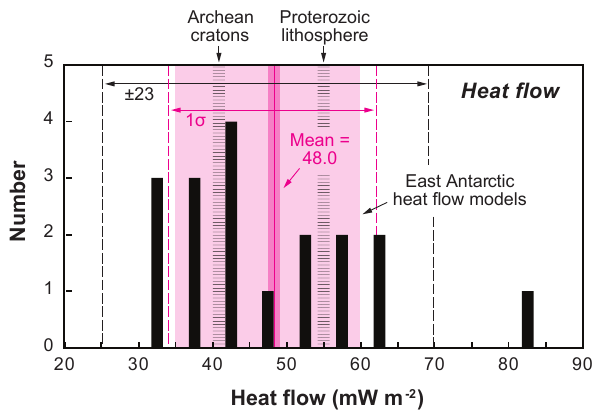
Figure 5. Histogram of heat flow values estimated from heat pro- duction in the glacial clasts. Mean value (magenta) is 48.0mWm − 2 ( n = 18) with a 1 σ standard deviation of 13.6mWm − 2 . Consider- ation of uncertainties in calculation of heat flow indicates an overall uncertainty of about ± 21mWm − 2 (see text). Range of heat flow values modeled for East Antarctica are shown for comparison (light pink; Van Liefferinge and Pattyn, 2013). Global average values for Archean cratons and Proterozoic lithosphere are shown by ruled bars (Nyblade et al.,